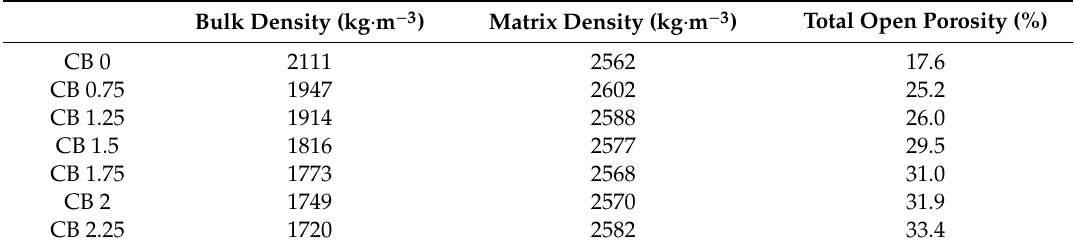
Table 2. Basic physical properties of the studied geopolymers.